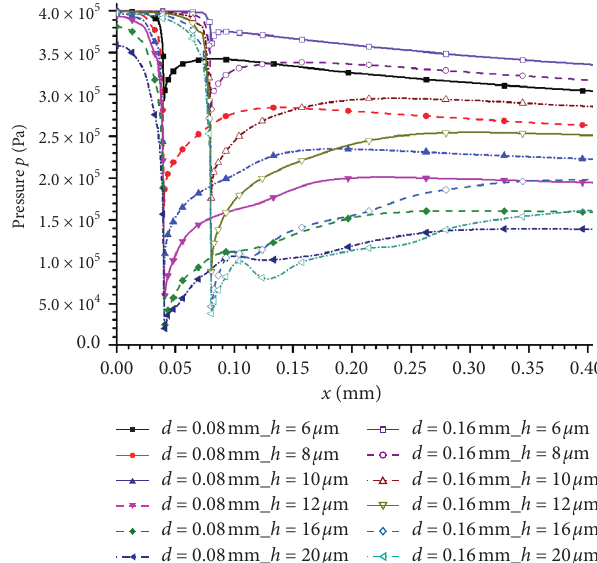
Figure 10: Curves D 1 of the pressure of the gas film at different h